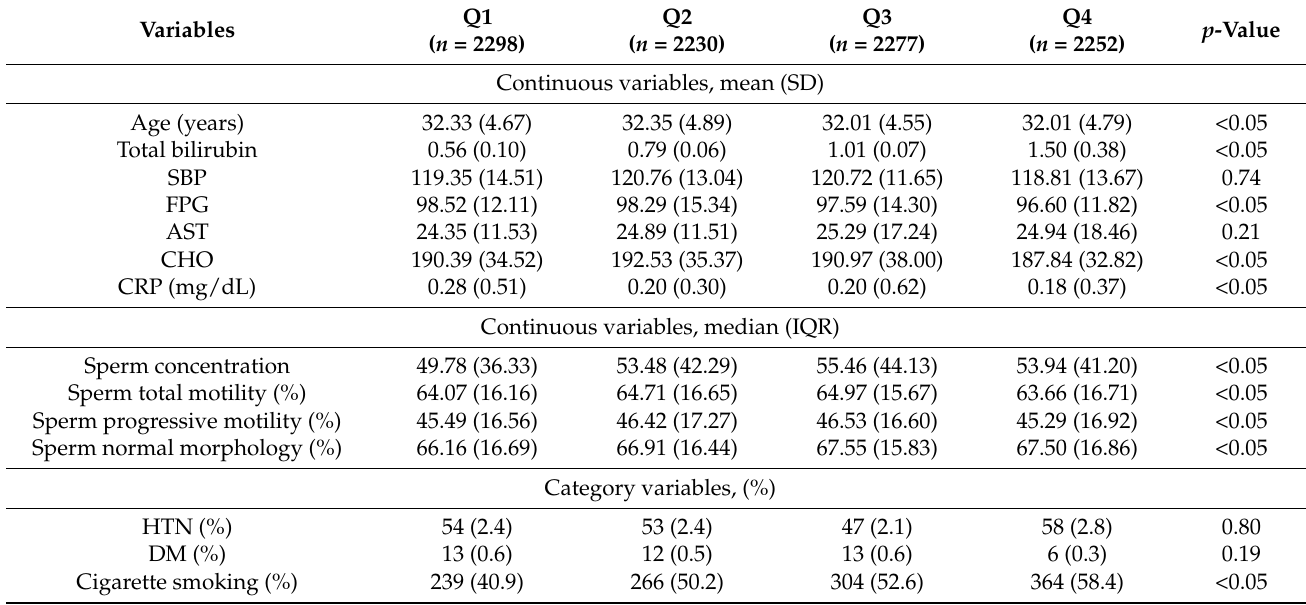
Table 1. Characteristics of participants in serum total bilirubin